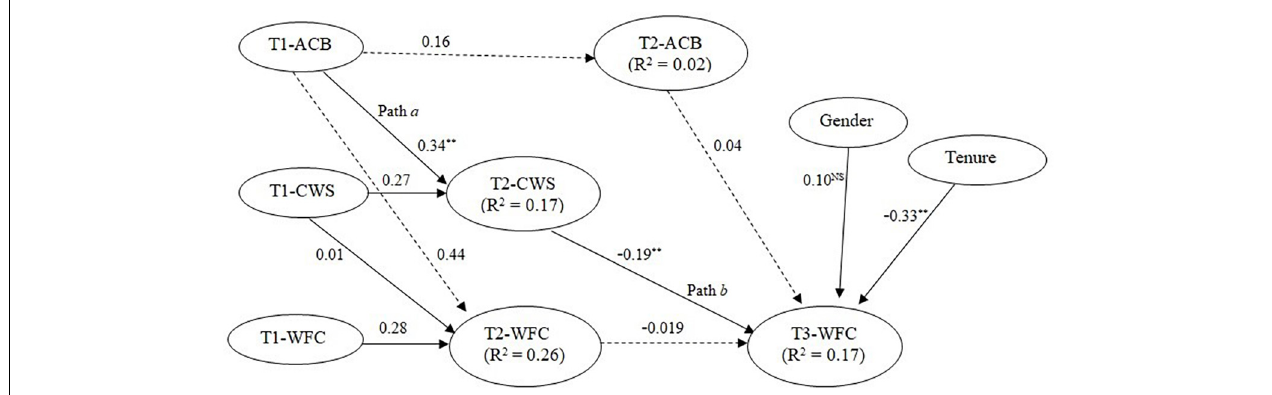
FIGURE 2 | Estimated longitudinal path model with direct and indirect effects. T1, Time 1; T2, Time 2; T3, Time 3; WFC, work–family conflict; ACB, altruistic citizenship behavior; CWS, coworker support. ** p < 0.01; * p < 0.05; NS , not